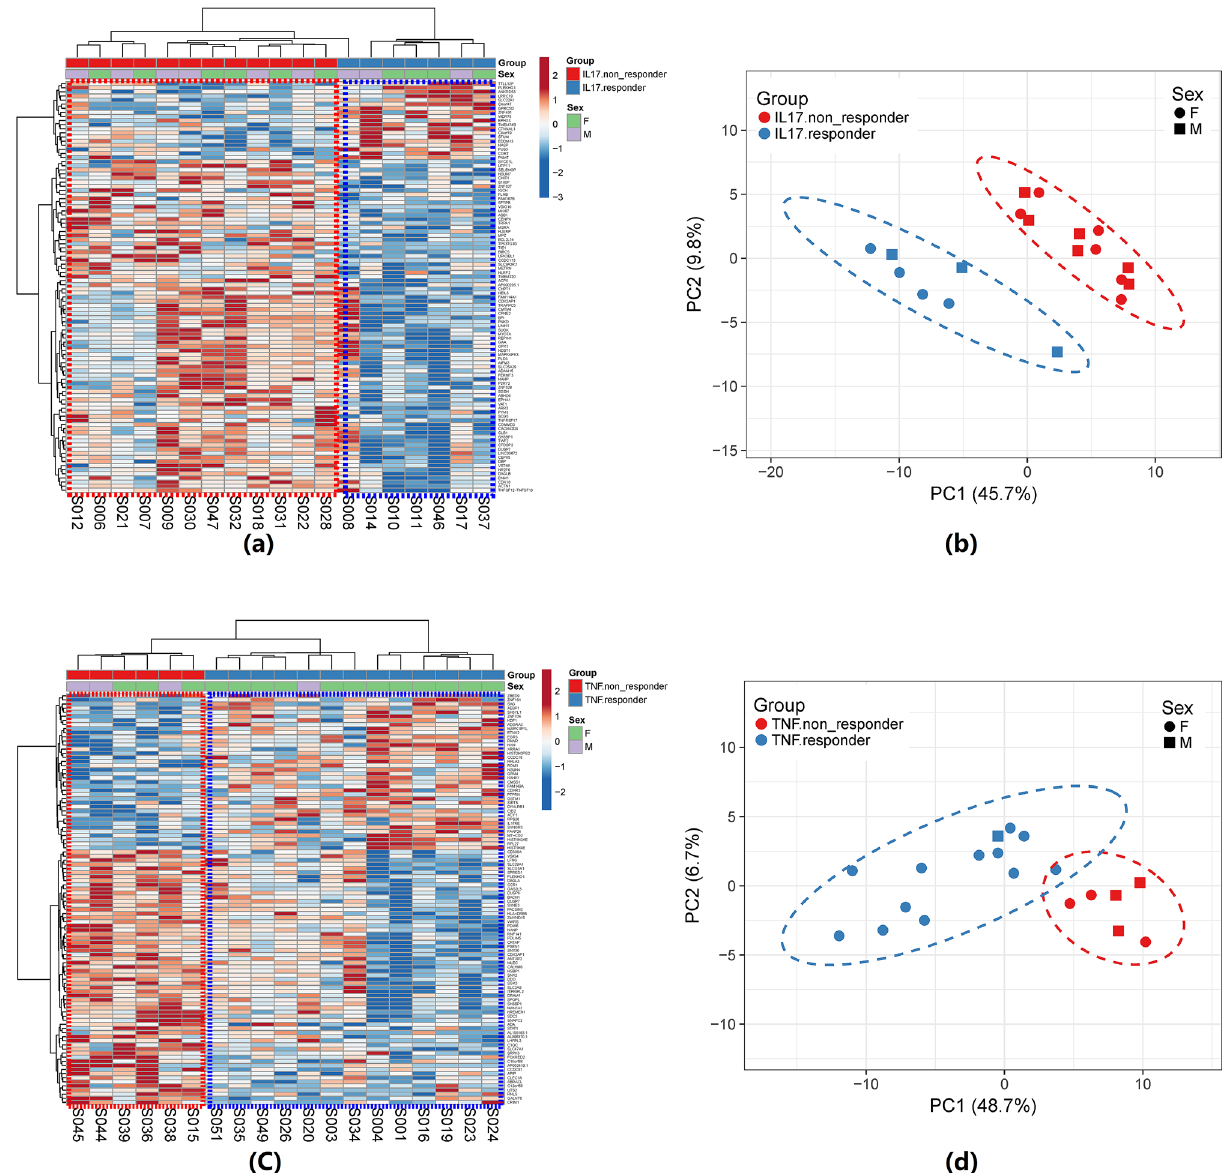
Figure 2. Sample Clustering and PCA analysis based on CD4 + cell transcriptomic data. The hierarchical clustering in heatmaps and 2D PCA plots with ellipses concentration clearly show separation of the responder and non-responders. In the heatmaps, columns are samples and rows are differentially expressed genes, the expression levels are presented as median-centered. Samples in the red-dashed lines were non-responders and samples in the blue-dashed lines were responders. ( a ) and ( b ) are heatmap and PCA plot for IL17i responder and non-responders; ( c ) and ( d ) are heatmap and PCA plot for TNFi responder and